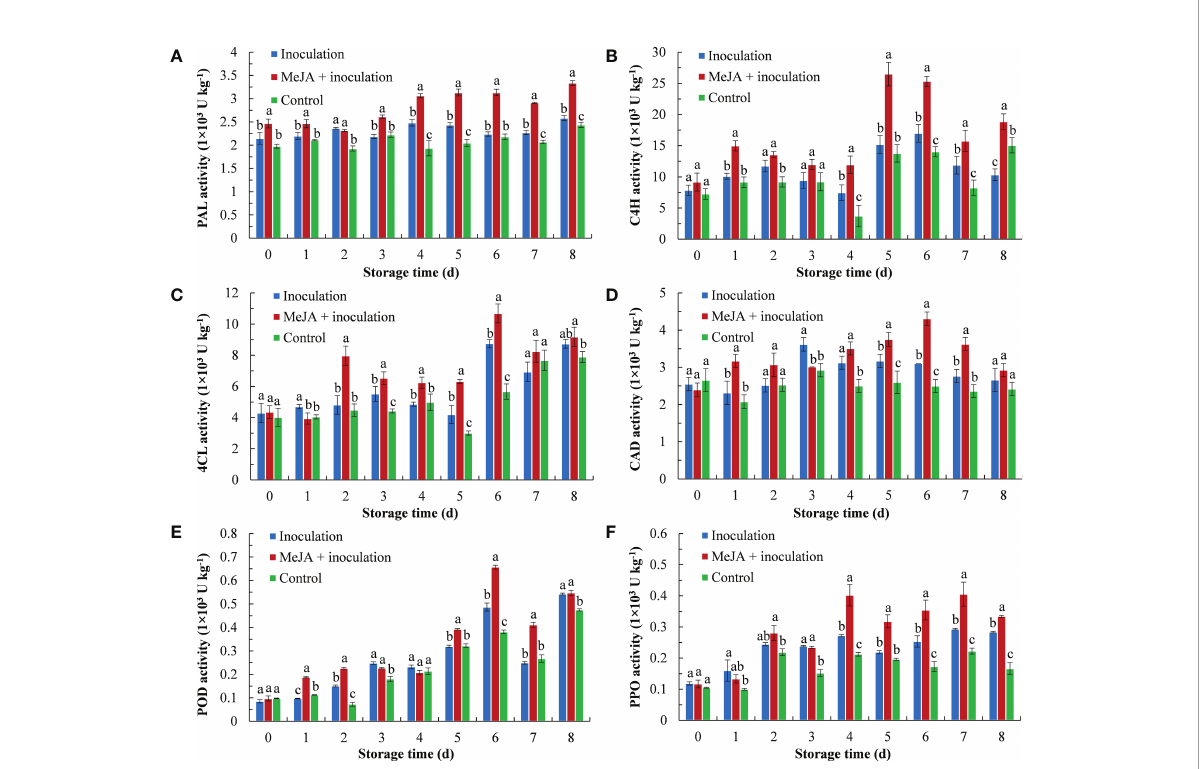
FIGURE 2 MeJA affected the activities of (A) PAL (phenylalanine ammonia lyase), (B) C4H (cinnamate 4-hydroxylase), (C) 4CL (4-coumarate: coenzyme A ligase), (D) CAD (cinnamyl alcohol dehydrogenase), (E) POD (peroxidase) and (F) PPO (polyphenol oxidase) in kiwifruit during storage time. Bars shows standard deviation (SD, n=3). Letters indicate signi fi cant differences at P < 0.05 level among the